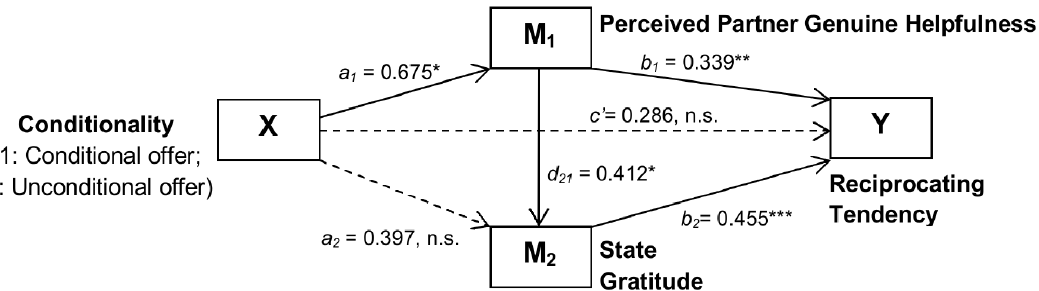
Fig. 3. A statistical diagram of the serial multiple mediator model for the Donor Intent Perception. Legends: Note. N 5 49; n.s. 5 Not Significant; *p , .05; **p , .01; ***p ,